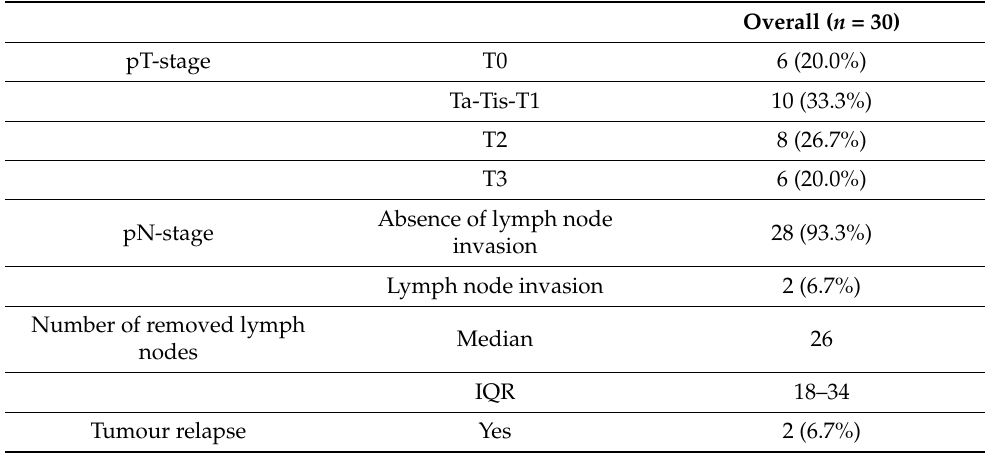
Table 3. Oncologic and functional outcomes of 30 patients with non-metastatic bladder cancer treated with robot-assisted radical cystectomy and Shell-shape ileal ortothopic neobladder